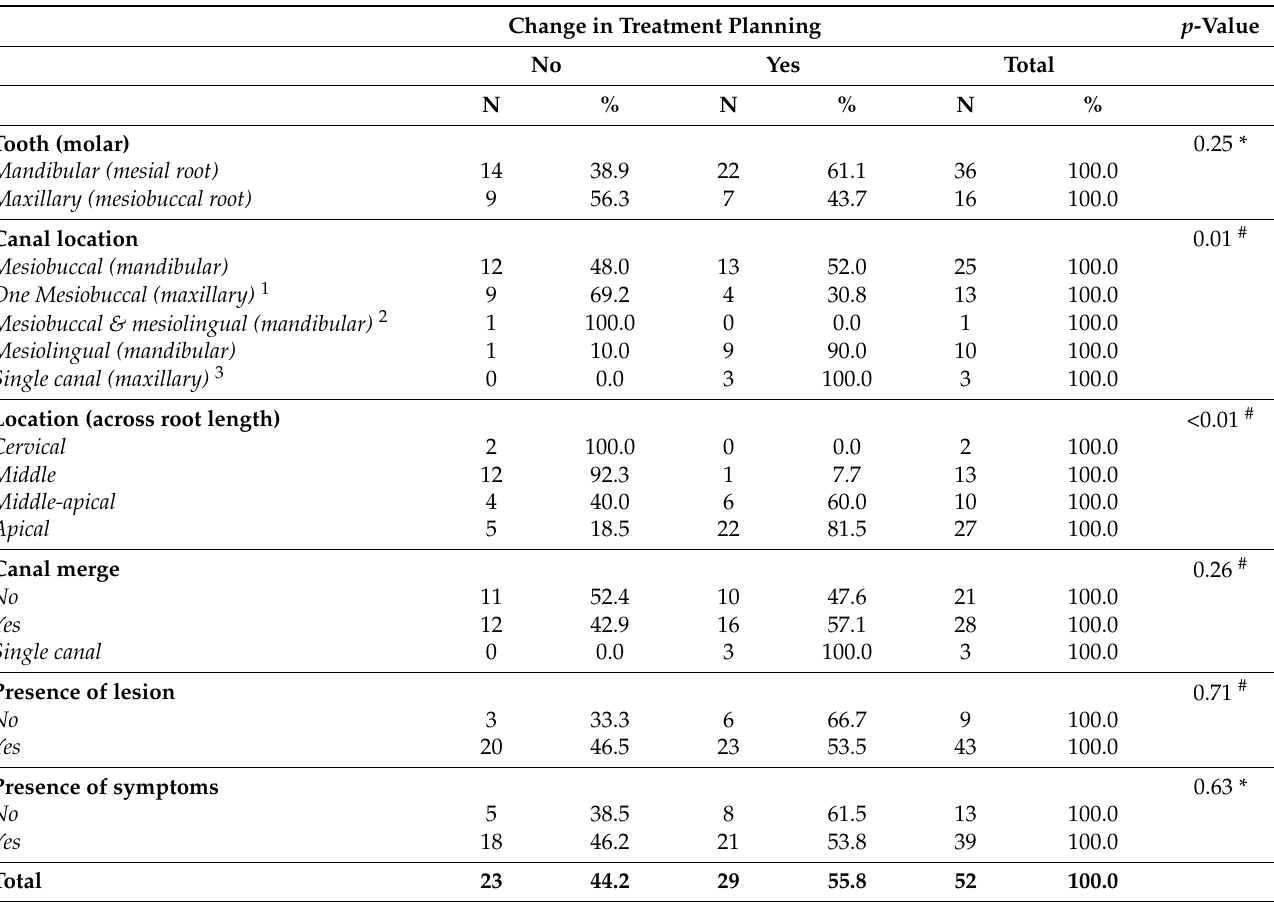
Table 1. Frequency distribution of characteristics of the sample according to whether there was a change or not in the initial treatment plan after CBCT evaluation for fractured instruments within the root canal ( n = 52).